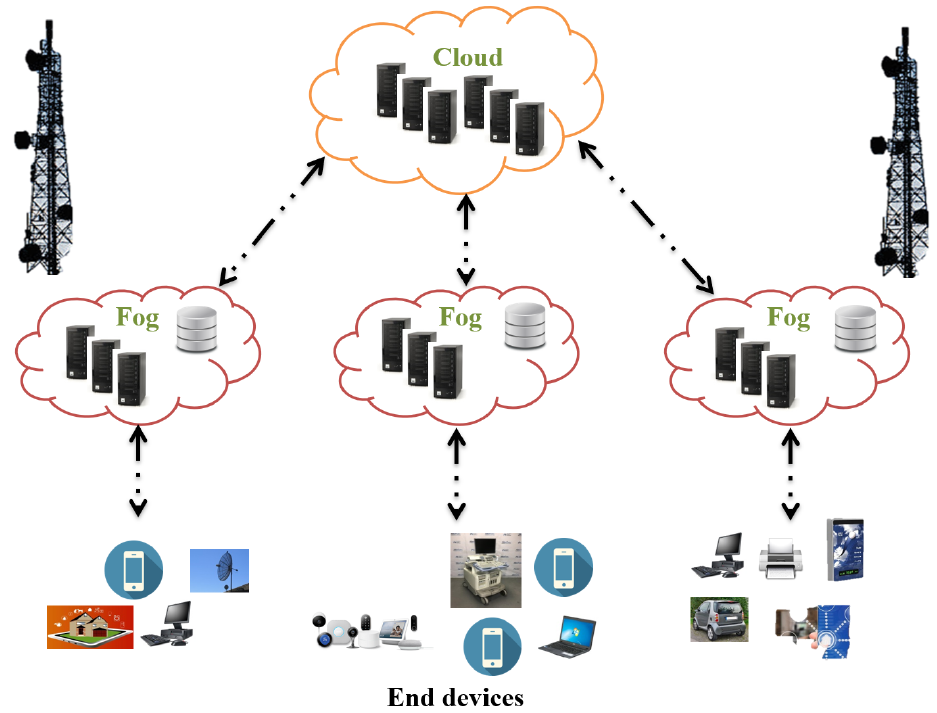
Figure 1. The fog computing